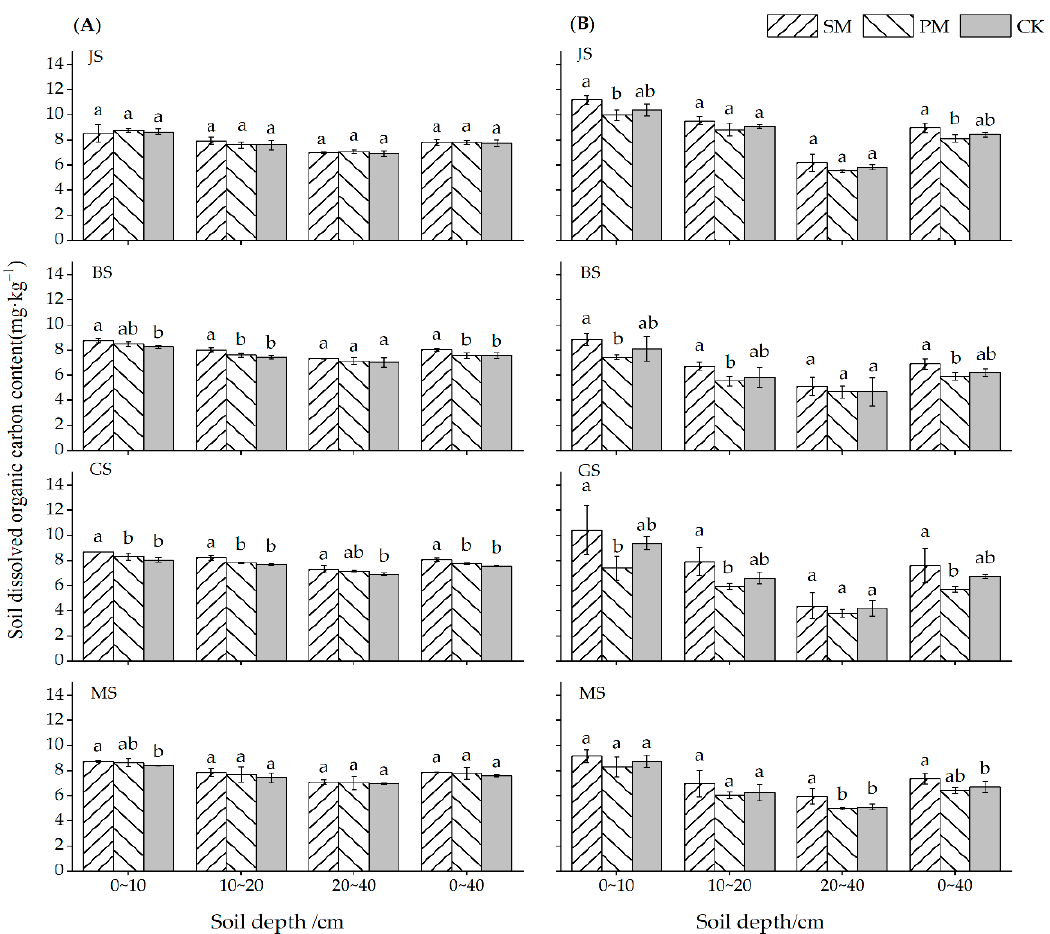
Figure 3. Soil dissolved organic carbon (DOC) in different growing periods of winter wheat. ( A )